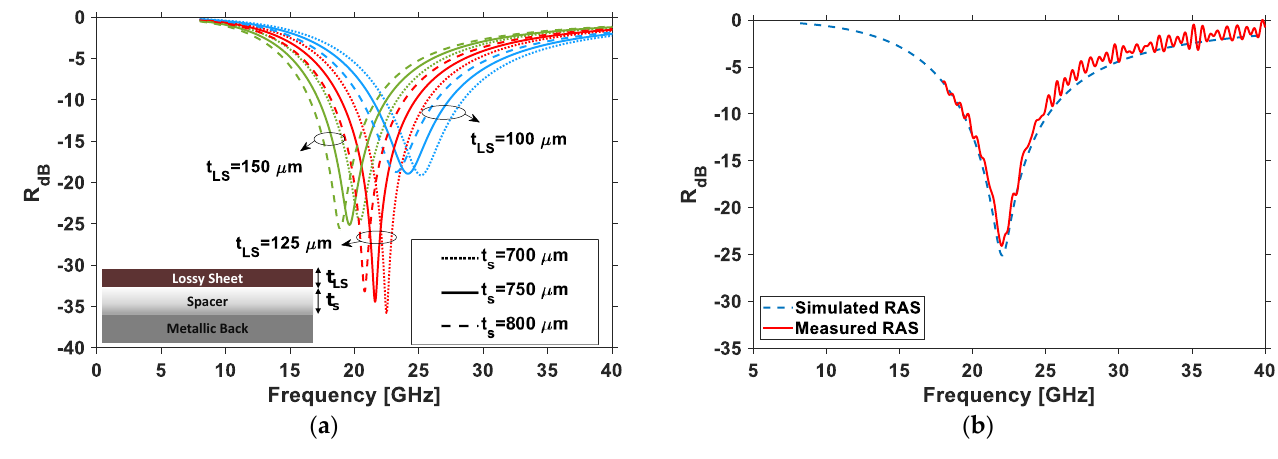
Figure 17. ( a ) Reflection as a function of different combinations of spacer and lossy thicknesses. ( b ) Comparison between measured (red line) and simulated (dashed blue line) reflection coefficients of RAS with t s = 750 µm and t LS = 120 µm.